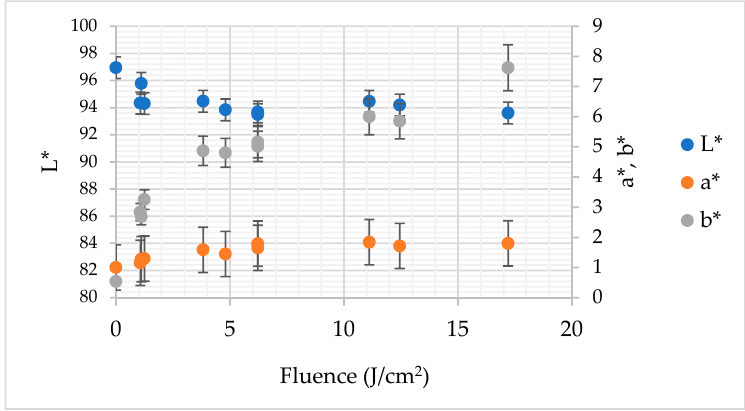
Figure 3. The impact of pulsed light on L*, a* and b* colour parameters of gallic acid aqueous solution.